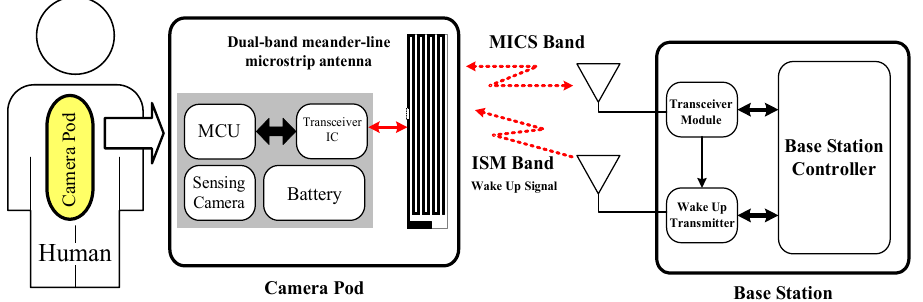
Figure 1. The MICS/ISM meander-line microstrip antenna encapsulated in an oblong-shaped pod, together with the base station .